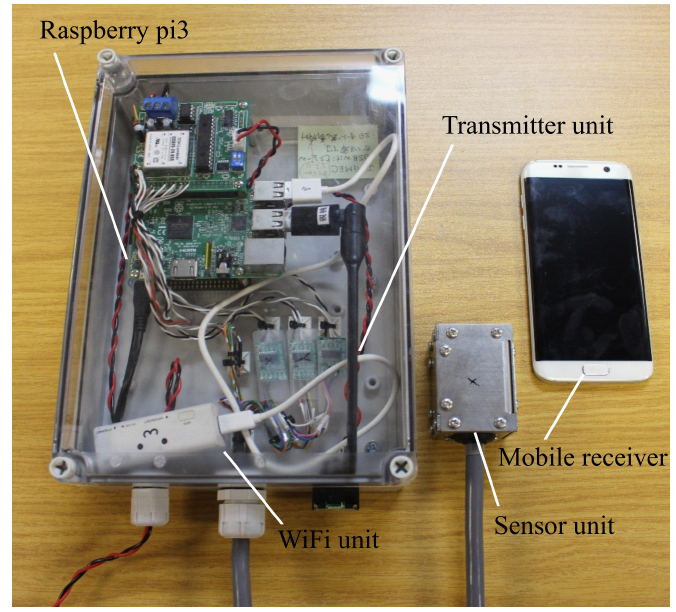
Figure 4. Sensor unit with a WiFi transmitter unit and mobile phone